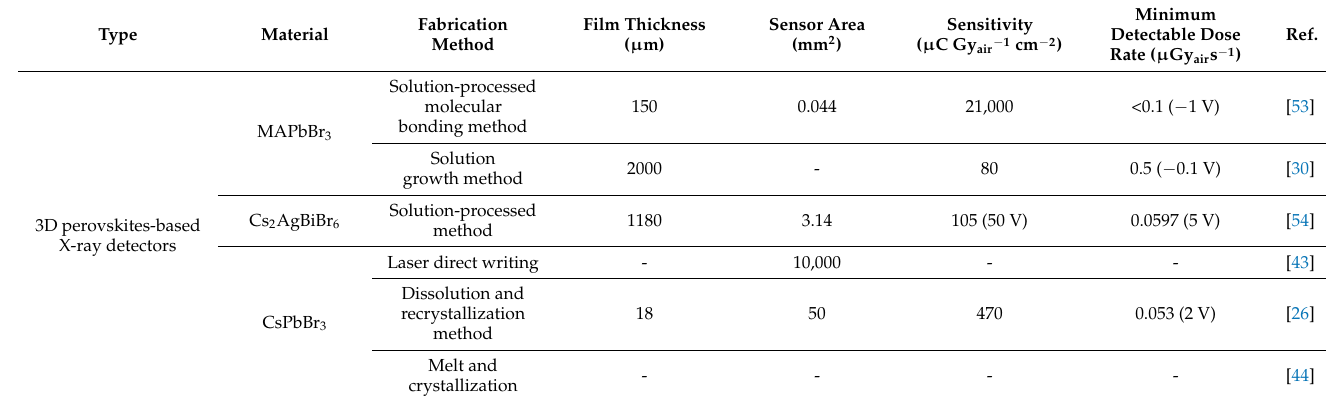
Table 2. The summarization of the performance of halide perovskite-based X-ray detectors.